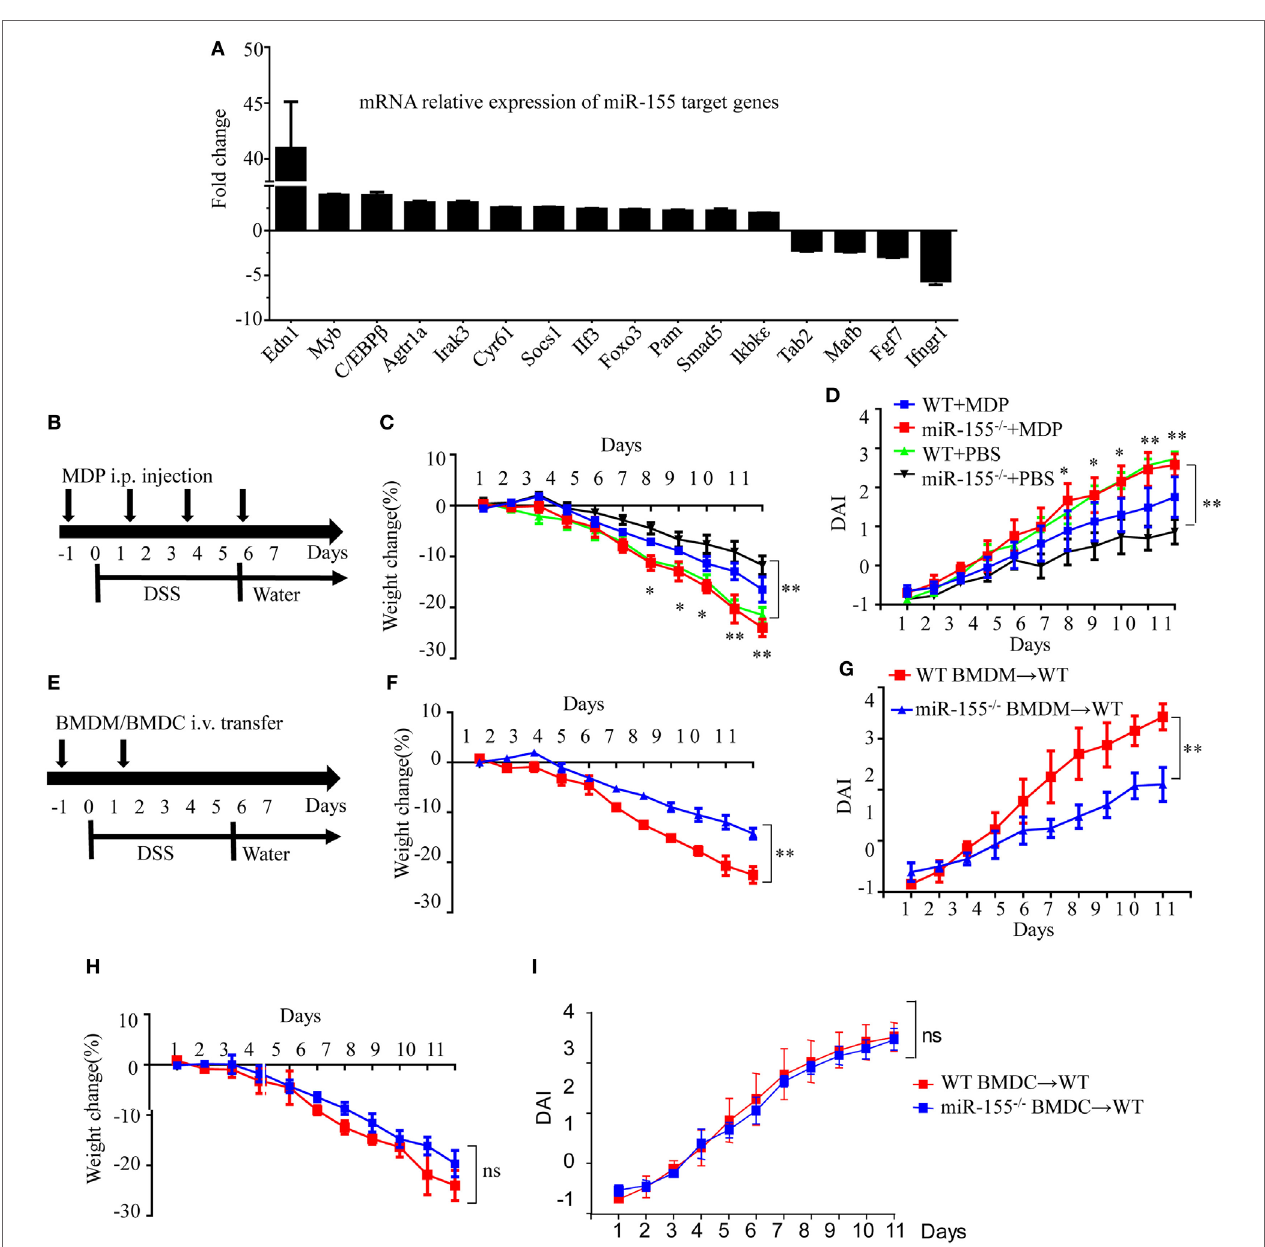
FigUre 3 | Macrophages play a critical role in miR-155 deficiency-mediated suppression of dextran sulfate sodium (DSS)-induced colitis. WT ( n = 3) or miR-155 − / − ( n = 3) mice were given 3% DSS in drinking water for 5 days, followed by regular drinking water for 6 days. (a) Total RNA was extracted from colon tissues and analyzed by the mouse miR-155 Targets RT 2 Profiler PCR Array (Qiagen), and the most differentially expressed target genes were ranked. (B–D) WT ( n = 12) or miR-155 − / − ( n = 13) mice were administrated intravenously with clodronate-liposomes (MDP) or control PBS-liposomes (PBS) as schematic protocol indicated during DSS colitis induction (B) . Body weight (c) and DAI (D) were monitored daily. * P < 0.05, ** P < 0.01 (WT + MDP) vs (miR-155 − / − + MDP) (Student’s t -test). (e) WT ( n = 12) mice were adoptive transferred intravenously with 5 million WT or miR-155 − / − BMDMs (BMDCs) as the schematic protocol indicated during DSS colitis induction. Body weight changes (F) and DAI (g) of WT mice with transferred WT or miR-155 − / − BMDMs were monitored throughout the study. ** P < 0.01, (miR-155 − / − BMDM → WT) vs (WT BMDM → WT) (Student’s t -test). (h,i) Body weight changes (h) and DAI (i) of WT mice with transferred WT or miR-155 − / − BMDCs were monitored throughout the study. ns (miR-155 − / − BMDCs → WT) vs (WT BMDCs → WT) (Student’s t -test). Data are representative of two independent experiments (mean and SD). WT, wild-type. MDPs clodronate-liposomes. BMDMs, bone marrow-derived macrophages. BMDCs, bone marrow-derived dendritic